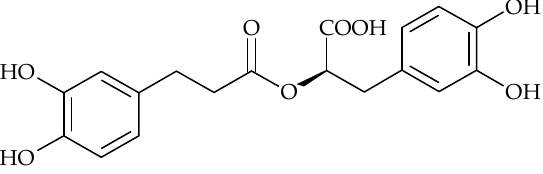
Figure 5. Chemical structure of rosmarinic acid.